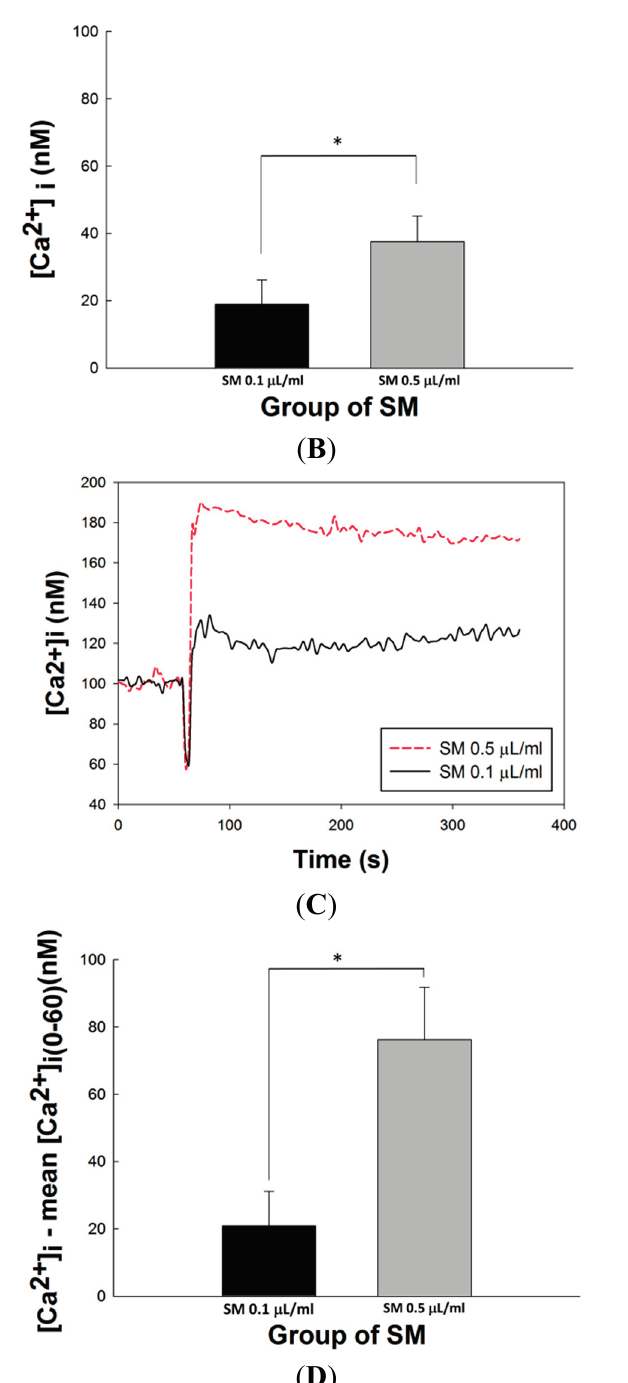
Figure 4. Effects of SM extracts on Ca 2+ signaling in primary LES cells. SM extracts were diluted as 0.5 μ L/mL or 0.1 μ L/mL in Ca 2+ -containing or Ca 2+ -free medium. The SM extracts were added at the 60th s ( A ) Mean concentration-response plots of SM-induced Ca 2+ signals in Ca 2+ -free medium; ( B ) The mean ([Ca 2+ ] i(61–360) − mean [Ca 2+ ] i(0–60) ) in primary LES cells in Ca 2+ -free medium during the interval of 61–360 s after SM (0.5 μ L/mL or 0.1 μ L/mL) treatment; ( C ) Mean concentration-response plots of SM-induced Ca 2+ signals in Ca 2+ -containing medium; ( D ) The mean ([Ca 2+ ] i(61–360) − mean [Ca 2+ ] i(0–60) ) in primary LES cells in Ca 2+ -containing medium during the interval of 61–360 s after SM (0.5 μ L/mL or 0.1 μ L/mL) treatment. * Significantly difference between these two groups at p <